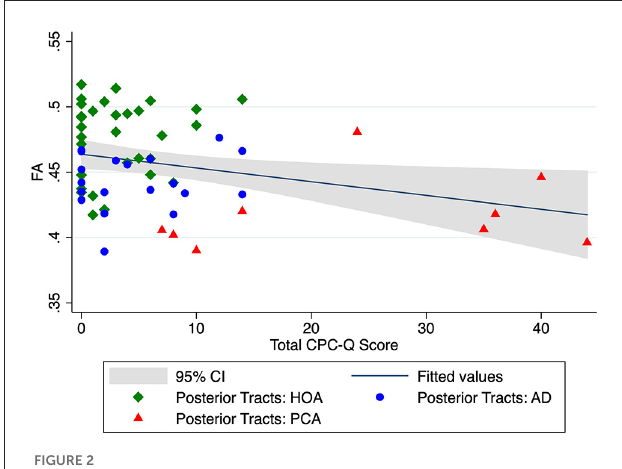
FIGURE2 Unadjusted relationship between mean DTI FA of localized posterior tracts and total CPC-Q